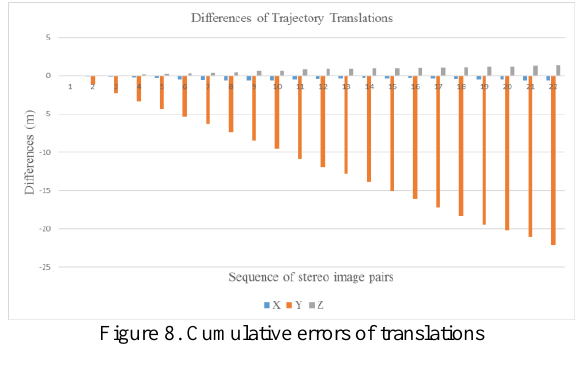
Figure 8. Cumulative errors of translations